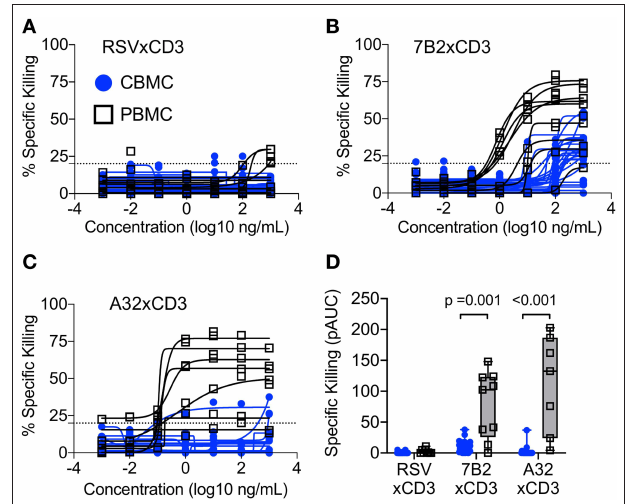
FIGURE 1 | Redirection of cytolytic T cells to autologous HIV-infected CD4 + T cells by HIV × CD3 DART molecules. The ability of T cells isolated from cord blood mononuclear cells (CBMC, blue lines, and symbols) and adult peripheral blood mononuclear cells (PBMC, black lines, and open symbols) to eliminate autologous CD4 + T cells infected with an HIV-1 molecular clone virus representing an infant postnatally-transmitted founder isolate (HIV-1 4403bmC5) after being redirected by (A) RSV × CD3 control DART molecules ( n = 25 CBMC samples, n = 9 PBMC samples), (B) 7B2 × CD3 DART molecules ( n = 25 CBMC samples, n = 9 PBMC samples), and (C) A32 × CD3 DART molecules ( n = 18 CBMC samples, n = 7 PBMC samples). Dashed line indicates the threshold for positivity. The positive areas under the dilution curves (pAUC) are presented in (D) with blue circles and bars representing assays performed with cells from CBMC and black/gray squares and bars representing assays performed with cells from adult PBMC. Box plots represent the interquartile ranges, horizontal lines indicate the medians, and error bars extend to the minimum and maximum observed values. Data are from 24h killing assays with a CD8 + effector to HIV-infected autologous CD4 + target cell ratio of 30:1.